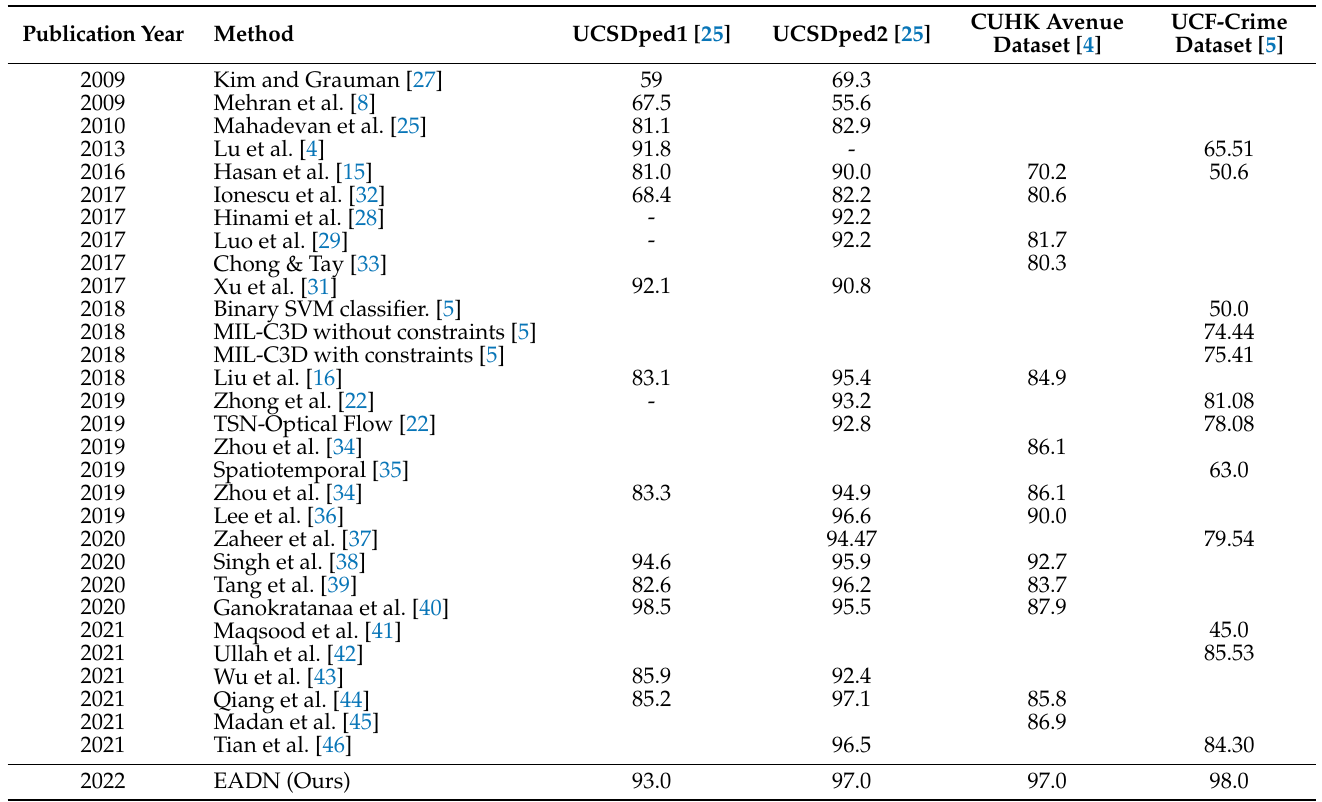
Figure 8. EADN training and validation loss graphs utilizing the UCF-Crime dataset. The training loss and the validation loss are plotted against the number of epochs. It is apparent from the graph that the model has a minimum loss after 35 epochs. After 35 epochs, the model tends to overfit. Table 5. A frame-based AUC comparison of accuracies of the EADN framework against existing approaches based on the UCSDped1, UCSDped2, CUHK Avenue, and UCF crime